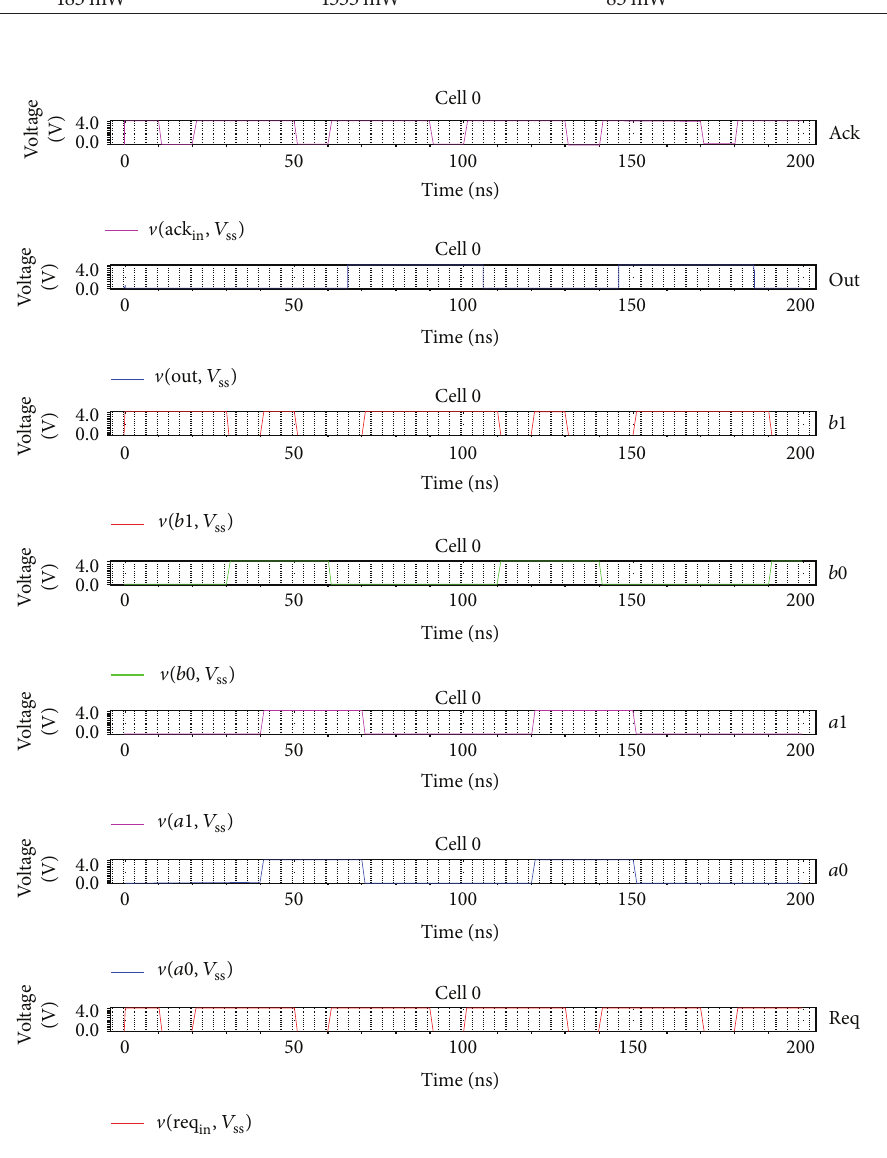
Figure 13: Output waveform of asynchronous Viterbi